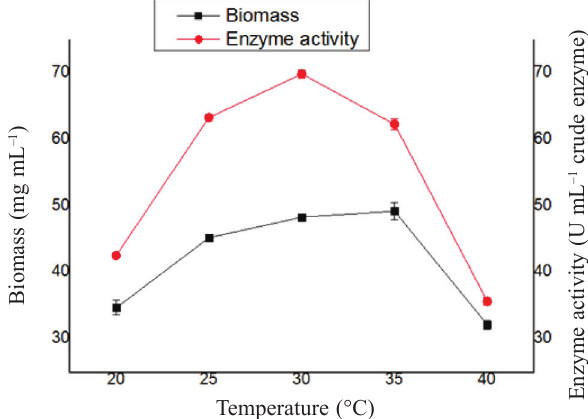
Fig. 2 – Effect of temperature on enzyme fermentation per- formance